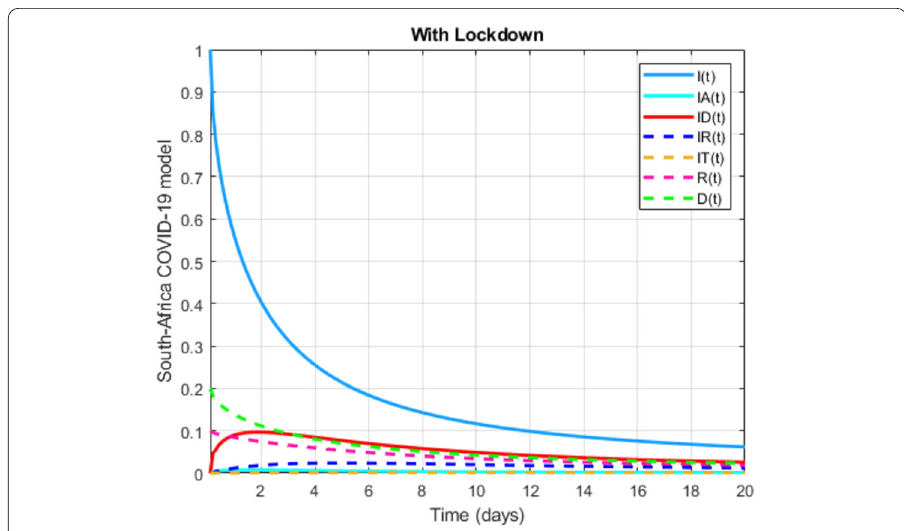
Figure 38 Numerical visualization for Covid-19 model in South Africa for α = 0.75